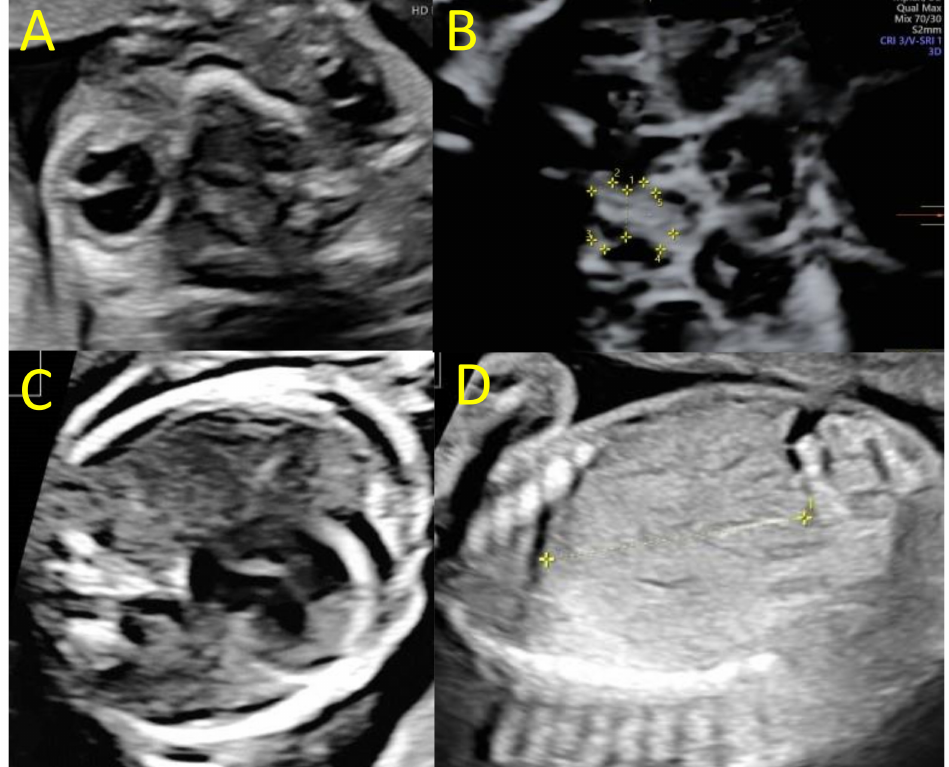
Figure 2. Fetal ultrasounds at 25 and 28 wg. ( A ) Trans-orbital axial plane with unilateral right microphthalmia (25 wg), ( B ) axial plane of the optic chiasm showing a global hypoplasia (1 = diameter of the optic chiasm at 5 mm) affecting the right tracts (2 = diameter of the right optic nerve at 2 mm; 5 = diameter of the right posterior tract at 1.8 mm, 28 wg), ( C ) cardiac four-chamber plane, with cardiomegaly and pericardial effusion (25 wg), ( D ) parasagittal plane of the fetal liver showing a hepatomegaly (diameter of the right liver lobe at 4.3 cm, 25